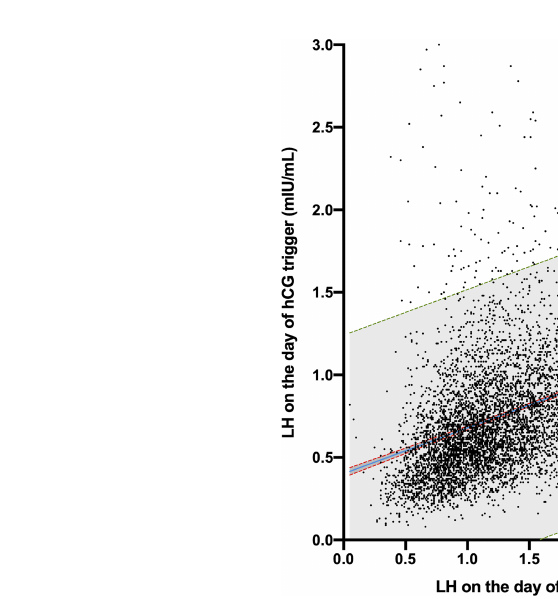
FIGURE 2 | Scatter plot of LH concentrations on the COS initiation day and hCG trigger day. The blue line is the linear regression equation line. The red dotted lines represent the 95% con fi dence bands of the best- fi t equation. The green dotted line is the 90% prediction band of the best- fi t equation.